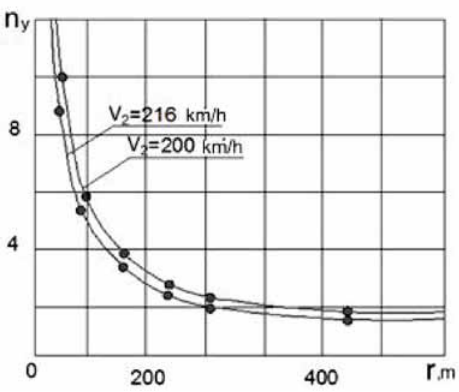
Fig. 3. Dependence of an overload on the radius of a ramp